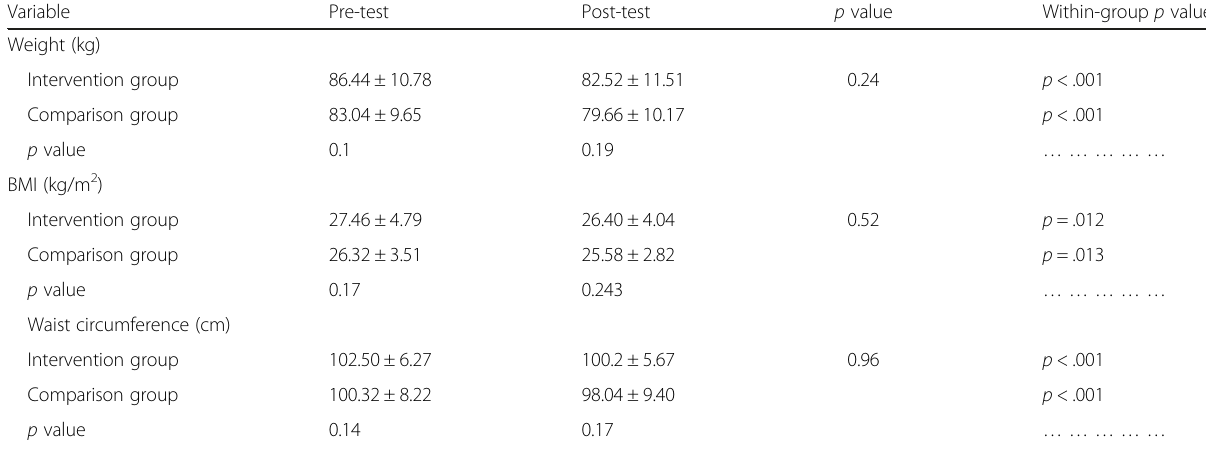
Table 2 Comparison of anthropometric measurements between treatment groups during the study Variable